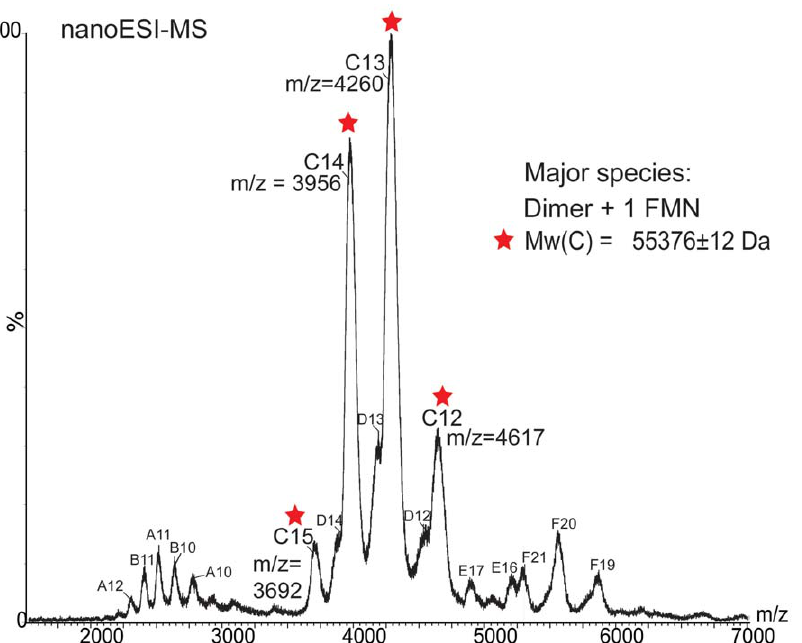
Figure 2. Nano-ESI mass spectrum of intact Rv2607 with co-purified FMN. The major species, C , has peaks with charges ranging from 15 + to 12 + in the 3500-4500 m/z range that correspond to a molecular weight of 55376 6 12. This experimental mass is consistent with the calculated mass for the complex of dimeric Rv2607 with one molecule of FMN bound (55442 Da), which is derived from the amino acid sequence of the 6x-histidine tagged Rv2607 (54986 Da; 27493 Da per protomer) and the molecular weight of FMN (456 Da). Monomeric tagged Rv2607 and truncated Rv2607 monomer (missing 10-11 residues), are present in solution and correspond to molecular weights of A (27450 6 52 Da) and B (26215 6 54 Da) respectively. A minor dimeric species comprised of full length and truncated monomer is represented as species D . Higher molecular weight oligomers (trimers E and tetramers F with molecular weights of 110.6 and 82.7 kDa, respectively) are electrospray-induced non-specific association of monomers and